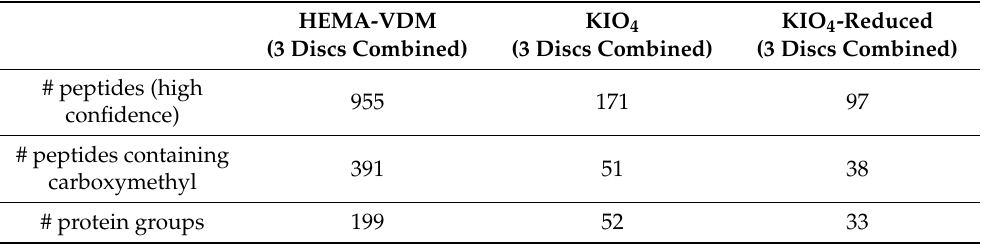
Table 2. Number of peptides and proteins measured in the HEMA-VDM-, KIO 4 - and KIO 4 -reduced